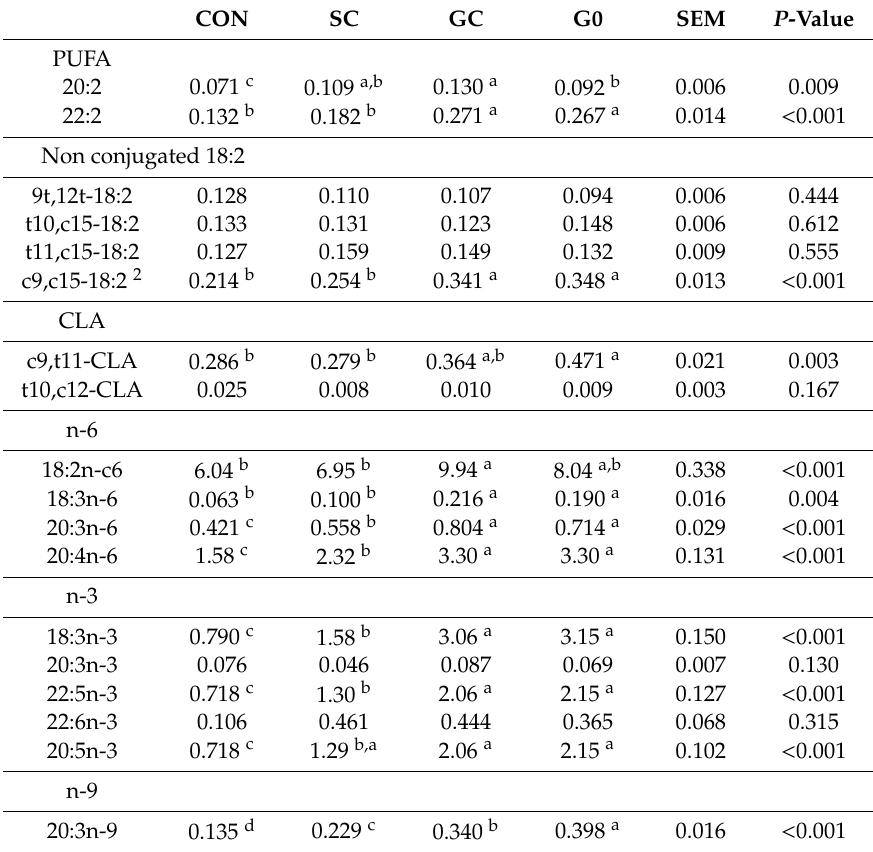
Table 6. Individual polyunsaturated fatty acid (PUFA) proportions (of total fatty acids 1 ) in the longissimus thoracis muscle from bulls assigned to one of the following systems: grass silage plus barley-based concentrate ad libitum (CON); grass silage ad libitum plus 5 kg of concentrate (SC); grazed grass without supplementation (G0) or grazed grass plus 0.5 kg of the dietary dry matter intake as concentrate (GC) until slaughter at 15